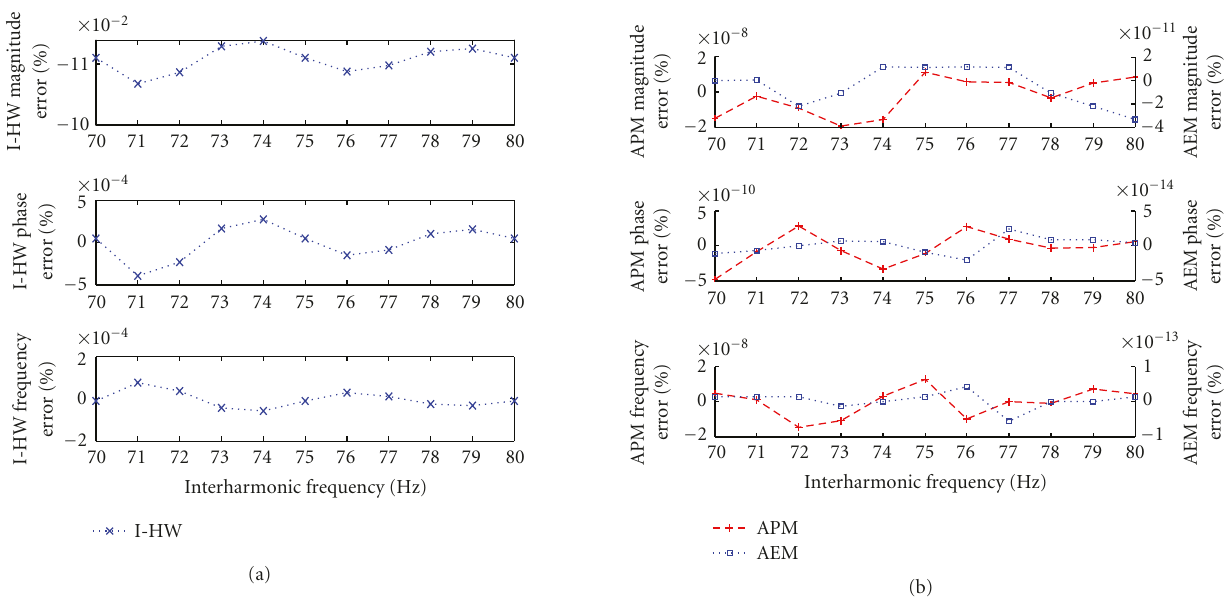
Figure 9: Case study 2: fundamental component amplitude, phase angle, and frequency error (in %) versus interharmonic frequency: (a) I-HW (dotted line x ), (b) APM (dotted line +) and AEM (dotted line (cid:3) ).